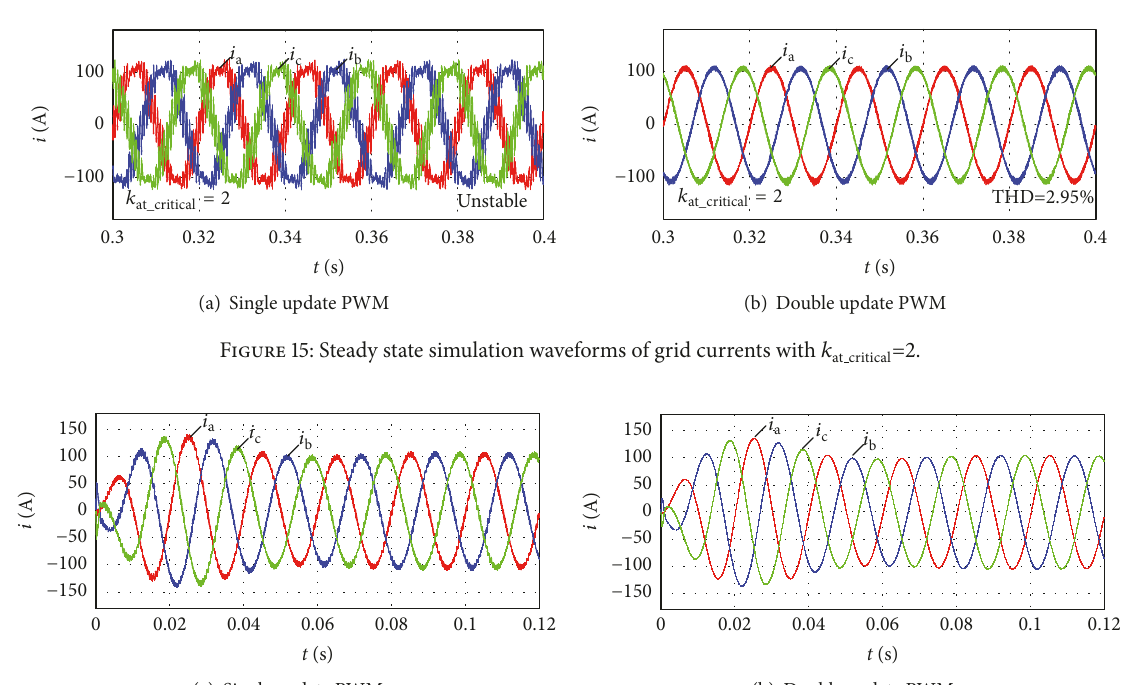
Figure 16: The dynamic simulation waveforms of grid currents.